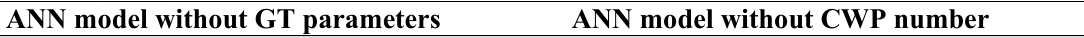
Sensitivity analysis of MCS model